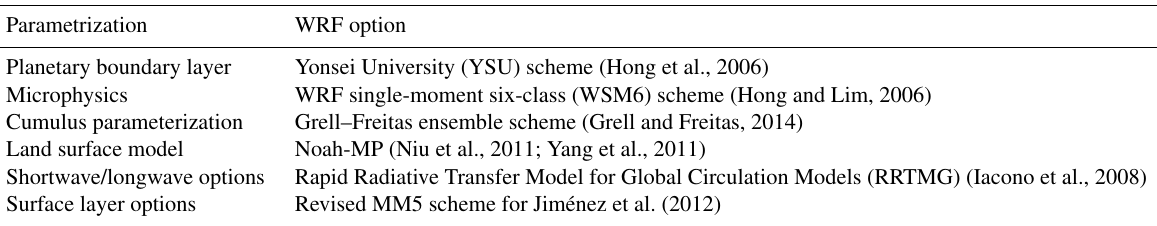
Table 1. WRF model configurations selected in this